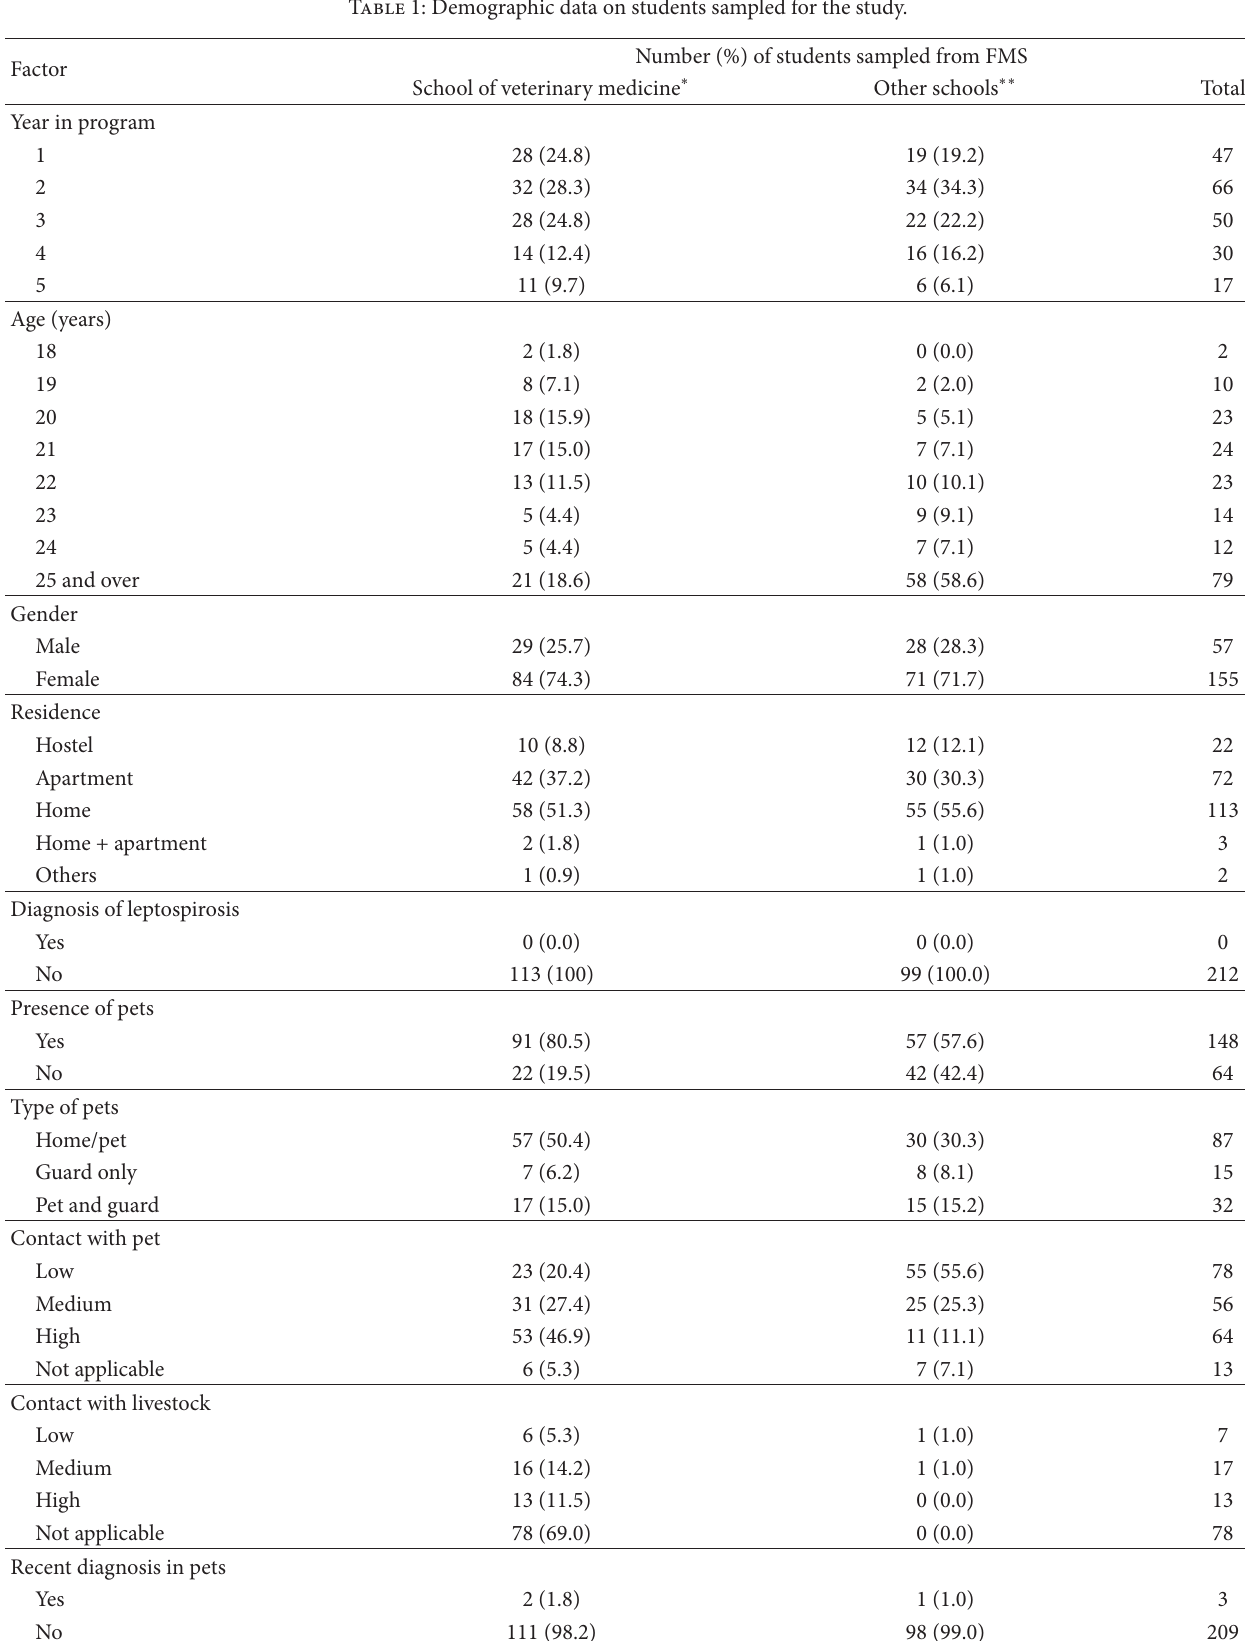
T 1: Demographic data on students sampled for the